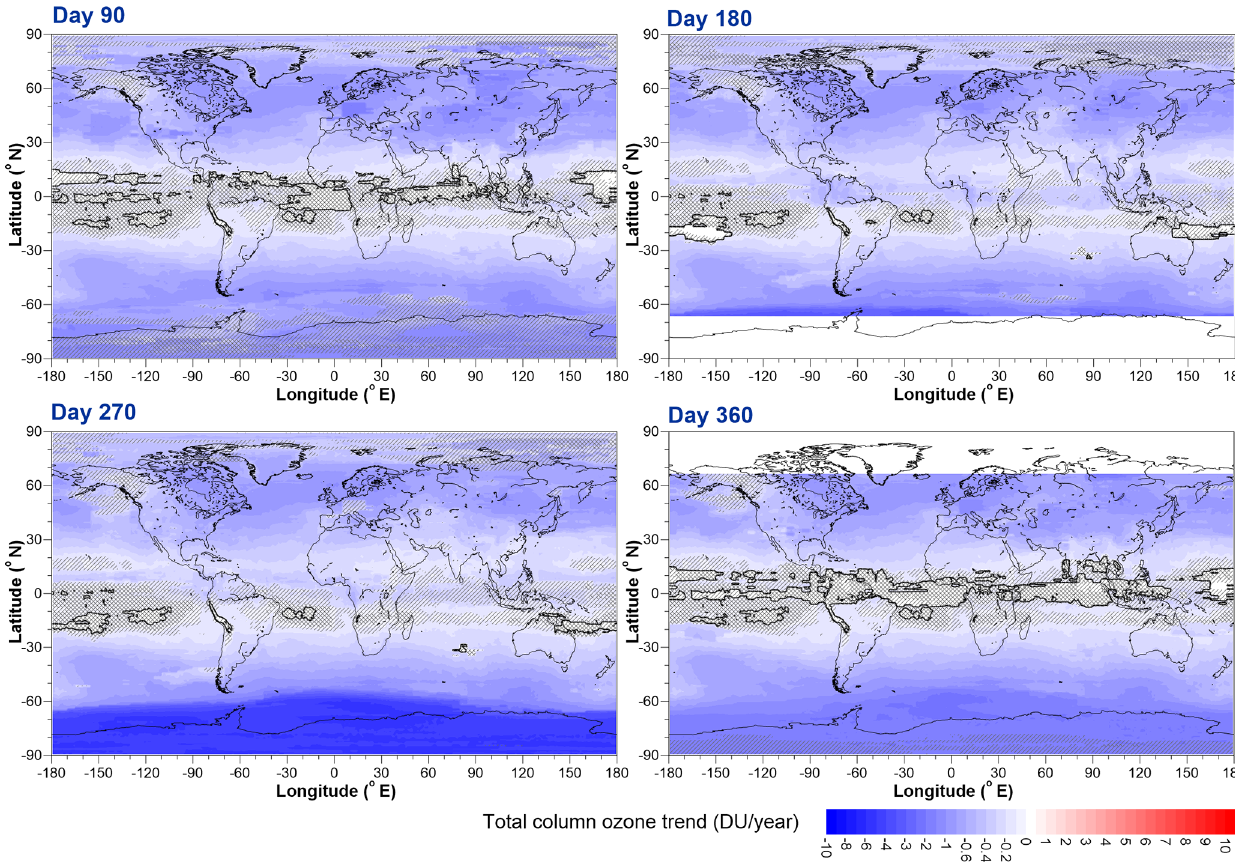
Figure 16. TCO trends for the period 1979 to 2000 evaluated at (a) day 90, (b) day 180, (c) day 270, and (d) day 360. The white areas at high latitudes in panels (b) and (d) result from there being insufficient data to establish meaningful trends during the polar night periods. The solid black line shows zero trend. Double hatched regions show where trends are not statistically different from zero at the 1 σ confidence level, while single hatched regions show where the trend is not statistically different from zero at the 2 σ confidence